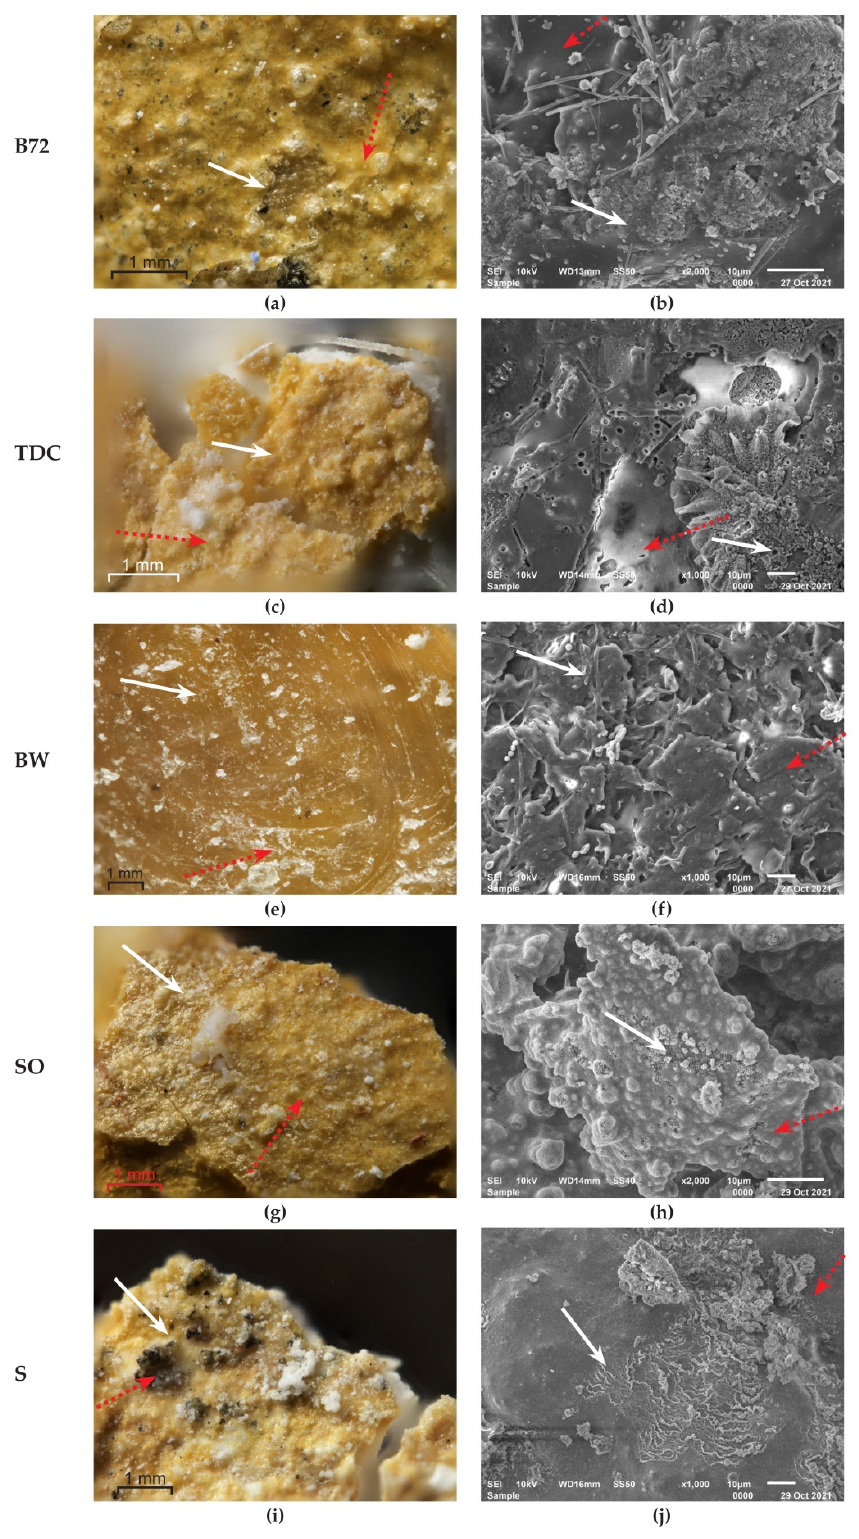
Figure 7. Organic compounds decomposition by lipases synthesized by Penicillium sp. BSL 3-2 on the yellow areas of the painted laboratory models; white arrows show decomposed areas; red dotted arrows show unchanged areas. ( a ) OM on Paraloid B72; ( b ) SEM on Paraloid B72; ( c ) OM on TDC; ( d ) SEM on TDC; ( e ) OM on Beeswax; ( f ) SEM on Beeswax; ( g ) OM on sunflower oil; ( h ) SEM on sunflower oil; ( i ) OM on Soot; ( j ) SEM on Soot.